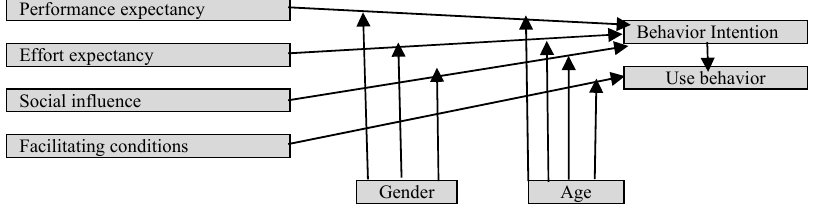
Fig. 1. UTAUT Framework Source: Venkatesh et al.,